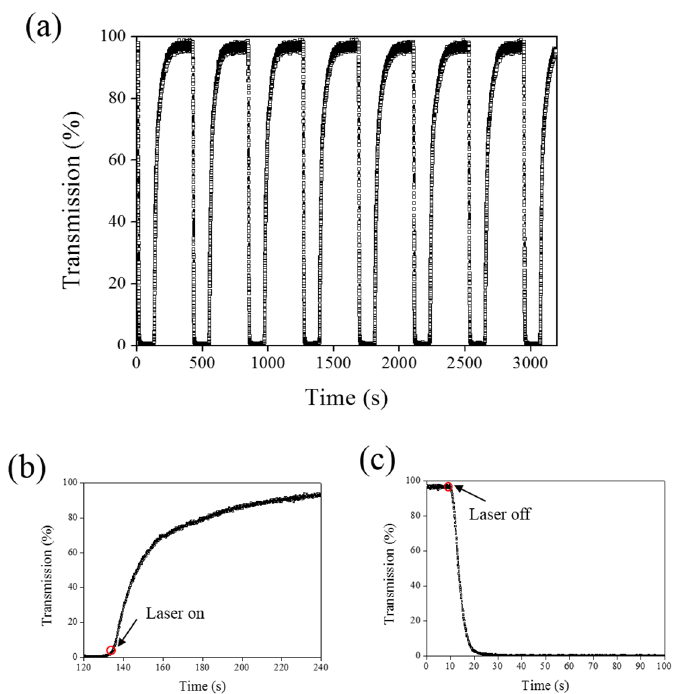
Figure 9. ( a ) Switching performance of AQ-A4-doped CLC under alternative on–off laser irradiation (660 nm); ( b ) time-dependent transmittance change under laser exposure; and ( c ) time-dependent change as turning off the laser light.